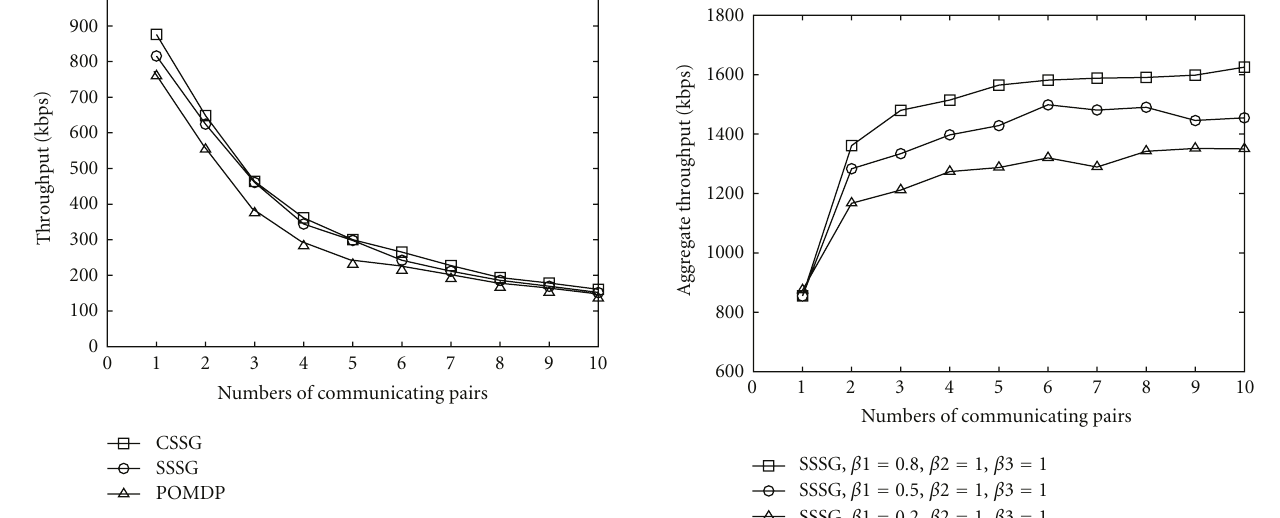
Figure 11: Average throughput; Channel 1: β = 0.8; Channel 2: β = 0.8; Channel 3: β = 1.0.